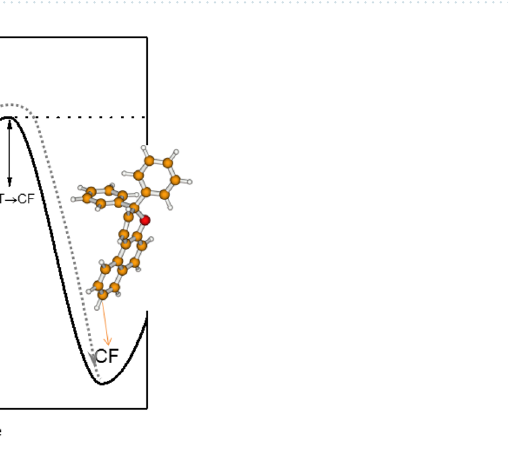
Figure 2. Thermal decoloration of TC → CF for compound 1 involves two reaction steps TC → INT and INT → CF , the first step is reversible 15